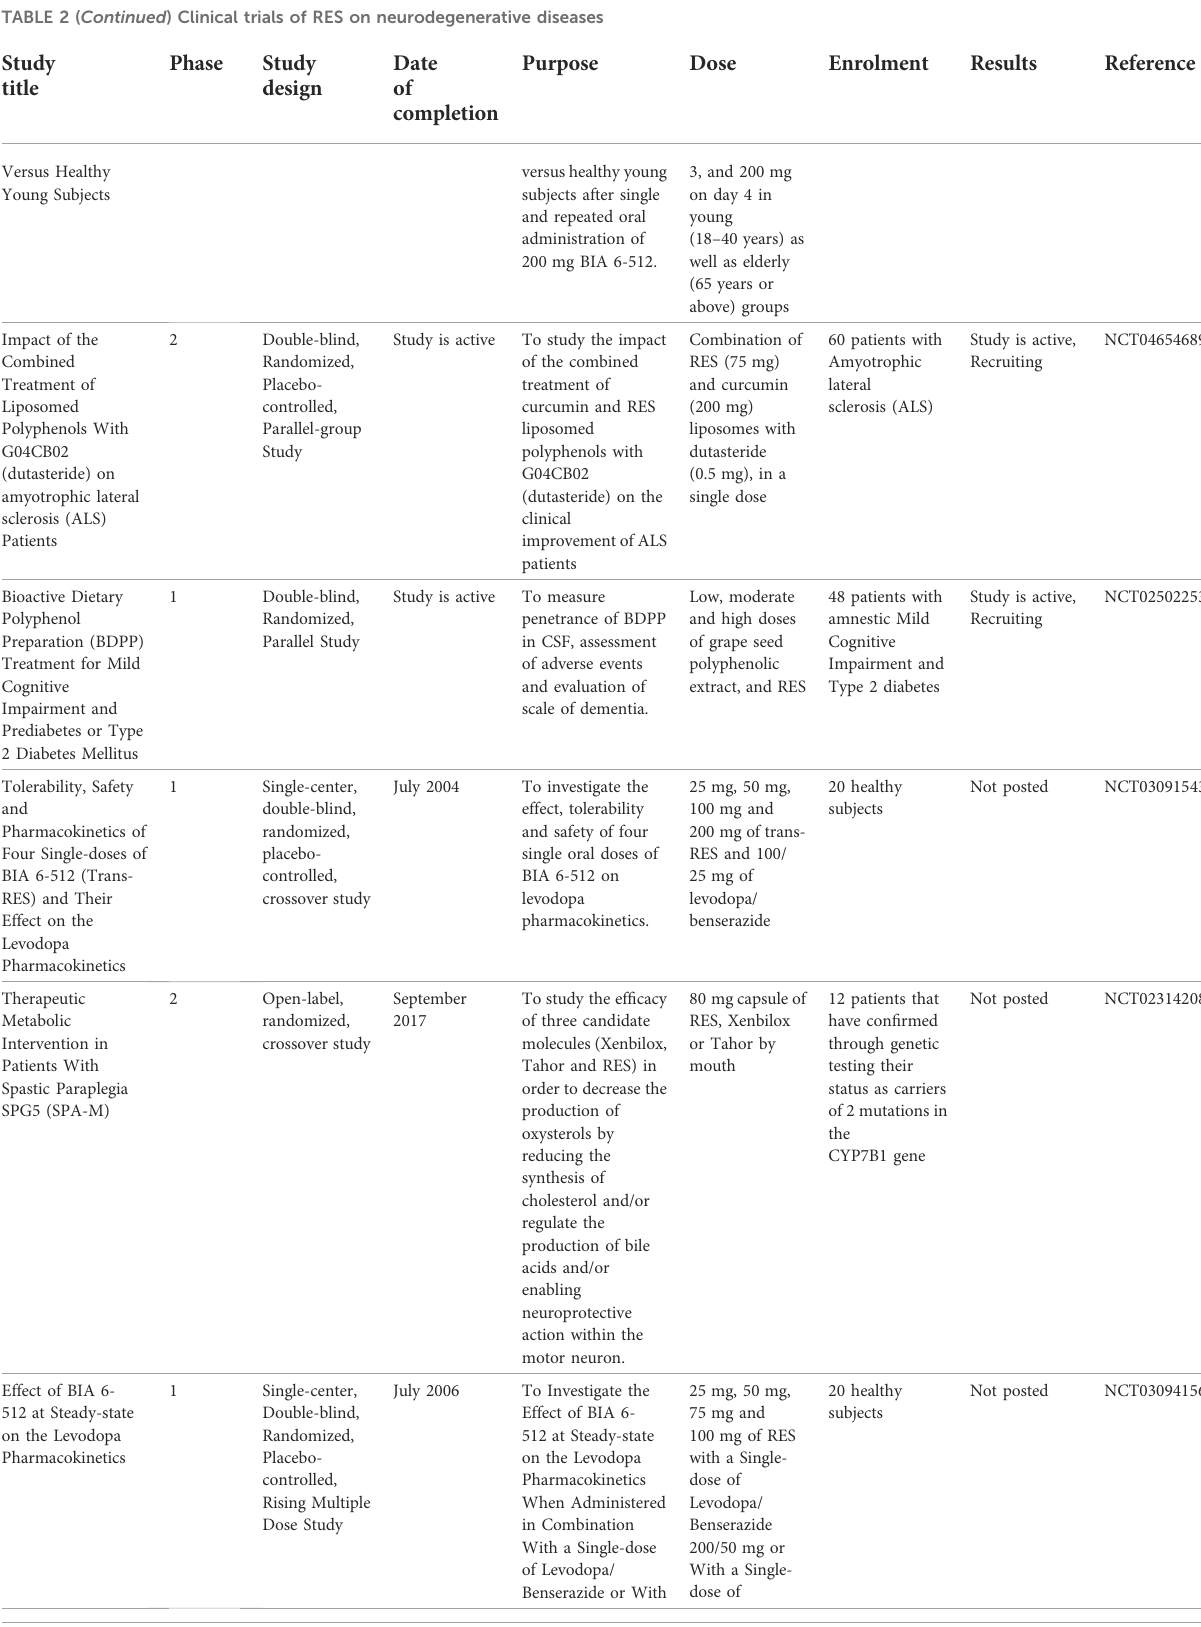
TABLE 2 ( Continued ) Clinical trials of RES on neurodegenerative